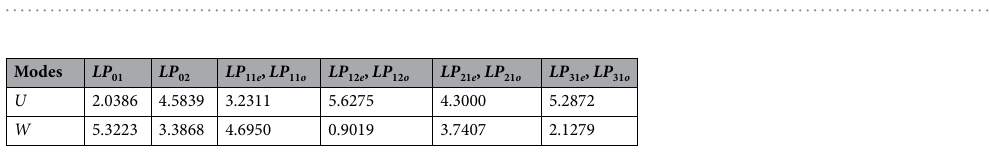
Figure 6. The Fourier spectrum of two holograms. ( a ) The Fourier spectrum of Fig. 2A1. ( b ) The Fourier spectrum of Fig. 4A1.